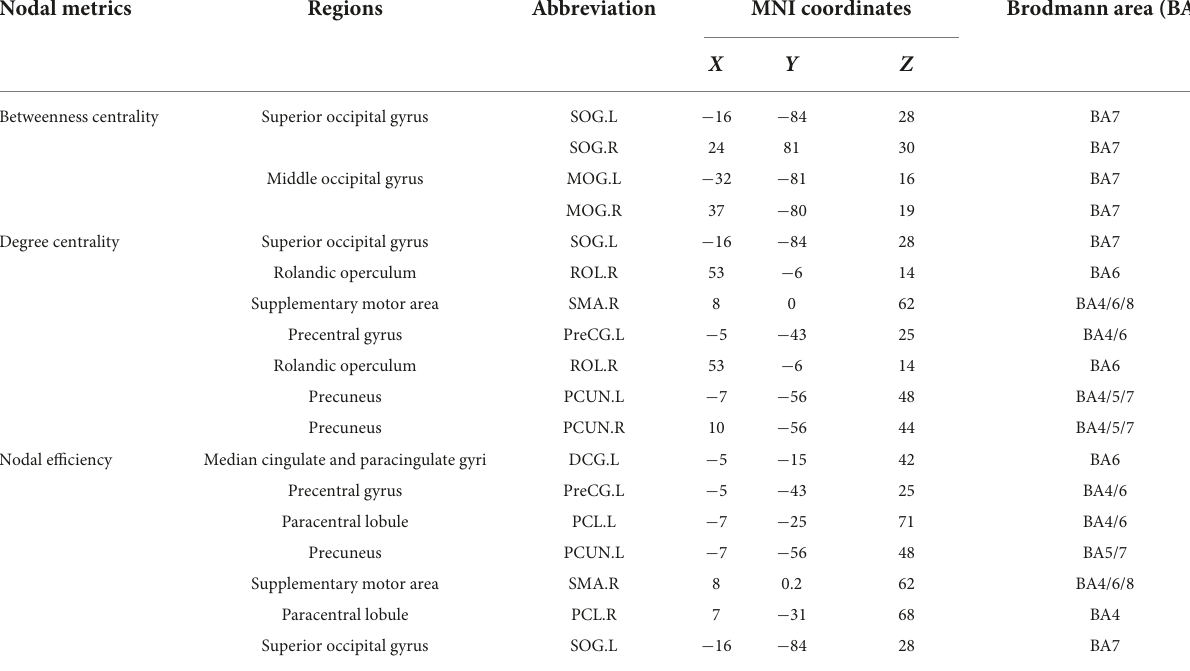
TABLE 2 Coordinates and abbreviations for the network nodes of the automated anatomical labeling (AAL) atlas. Nodal